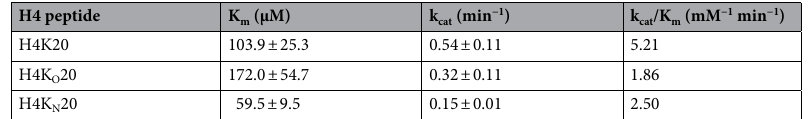
Table 1. Kinetics parameters for SETD8-catalyzed methylation of H4K20, H4K O 20 and H4K N